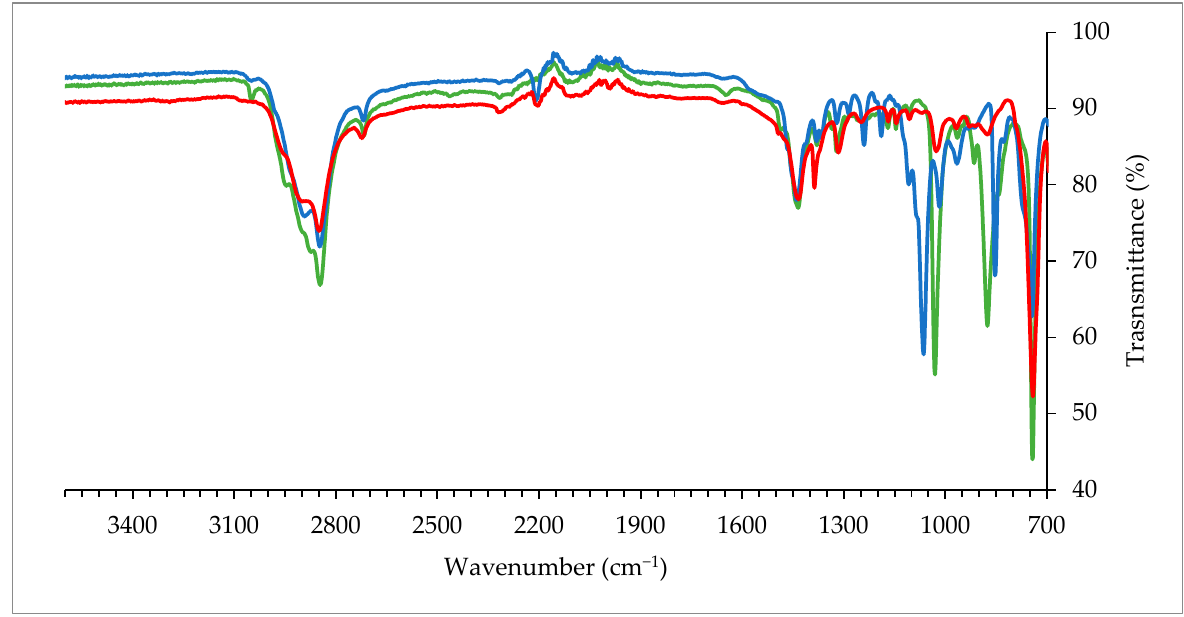
Figure 4. Infrared spectra of 1 (red), 2 (blue), and 3 (green).